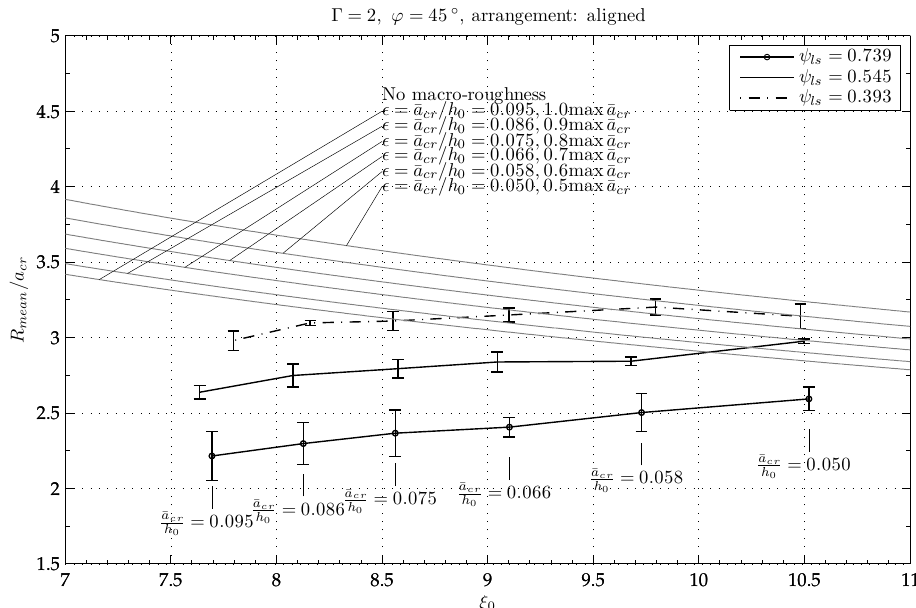
Fig. 13. The relative wave run-up ( R mean /a cr ) as a function of the surf similarity parameter ( ξ 0 ), 0 = 2. The experimental data are plotted according to the individual long-shore obstruction ratio. The error bars indicate the variation of the number of macro-roughness element rows. The grey parallel graphs indicate the relative run-up without the interaction with macro-roughness. The non-linearity of the applied waves is indicated as text which always refers to all error bars in the vertical above.